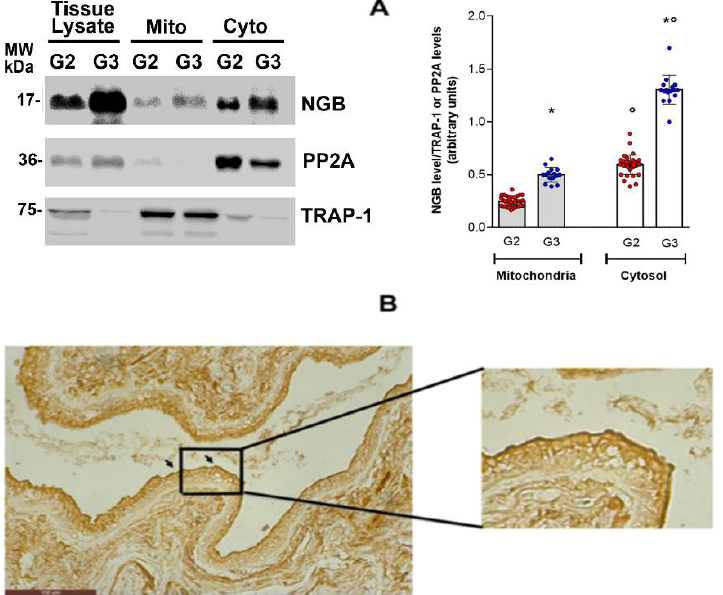
Figure 4. NGB localization in breast tissues. ( A ) Representative Western blot image (left panel) of NGB levels in whole tissue (Tissue lysate) and in subcellular (Mitochondria-Mito, Cytosol-Cyto) fractions of G2 and G3 samples and densitometric analysis (right panel) of NGB levels in subcellular fractions among all available tissues (G2 n = 38, G3 n = 15, respectively). The amount of protein was normalized by comparison with the cytosolic marker protein phosphatase 2A (PP2A) and the mitochondrial marker tumor necrosis factor-associated protein 1 (TRAP-1). Data are means ± SD. p < 0.01 was determined with ANOVA followed by Bonferroni post-test vs. G2 (*) samples and vs. correspondent mitochondrial fraction (°). ( B ) Representative image shows positive NGB staining (mouse monoclonal Clone 6G1.1 anti-NGB MERCK) in the epithelial cells of the tumoral section in a G2 ERα+ breast cancer tissue sample (total n = 10). The scale bar is 100 μm/cm. The black square refers to image detail reported on the right as a digital magnification.